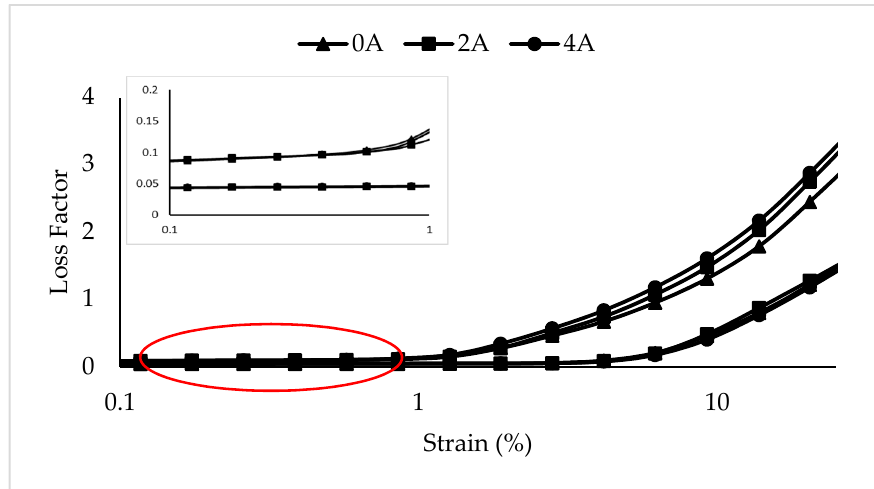
Figure 6. Loss factors of MRE and Gr-MRE at different strain amplitudes at magnetic fields of 0, 2, and 4 A.